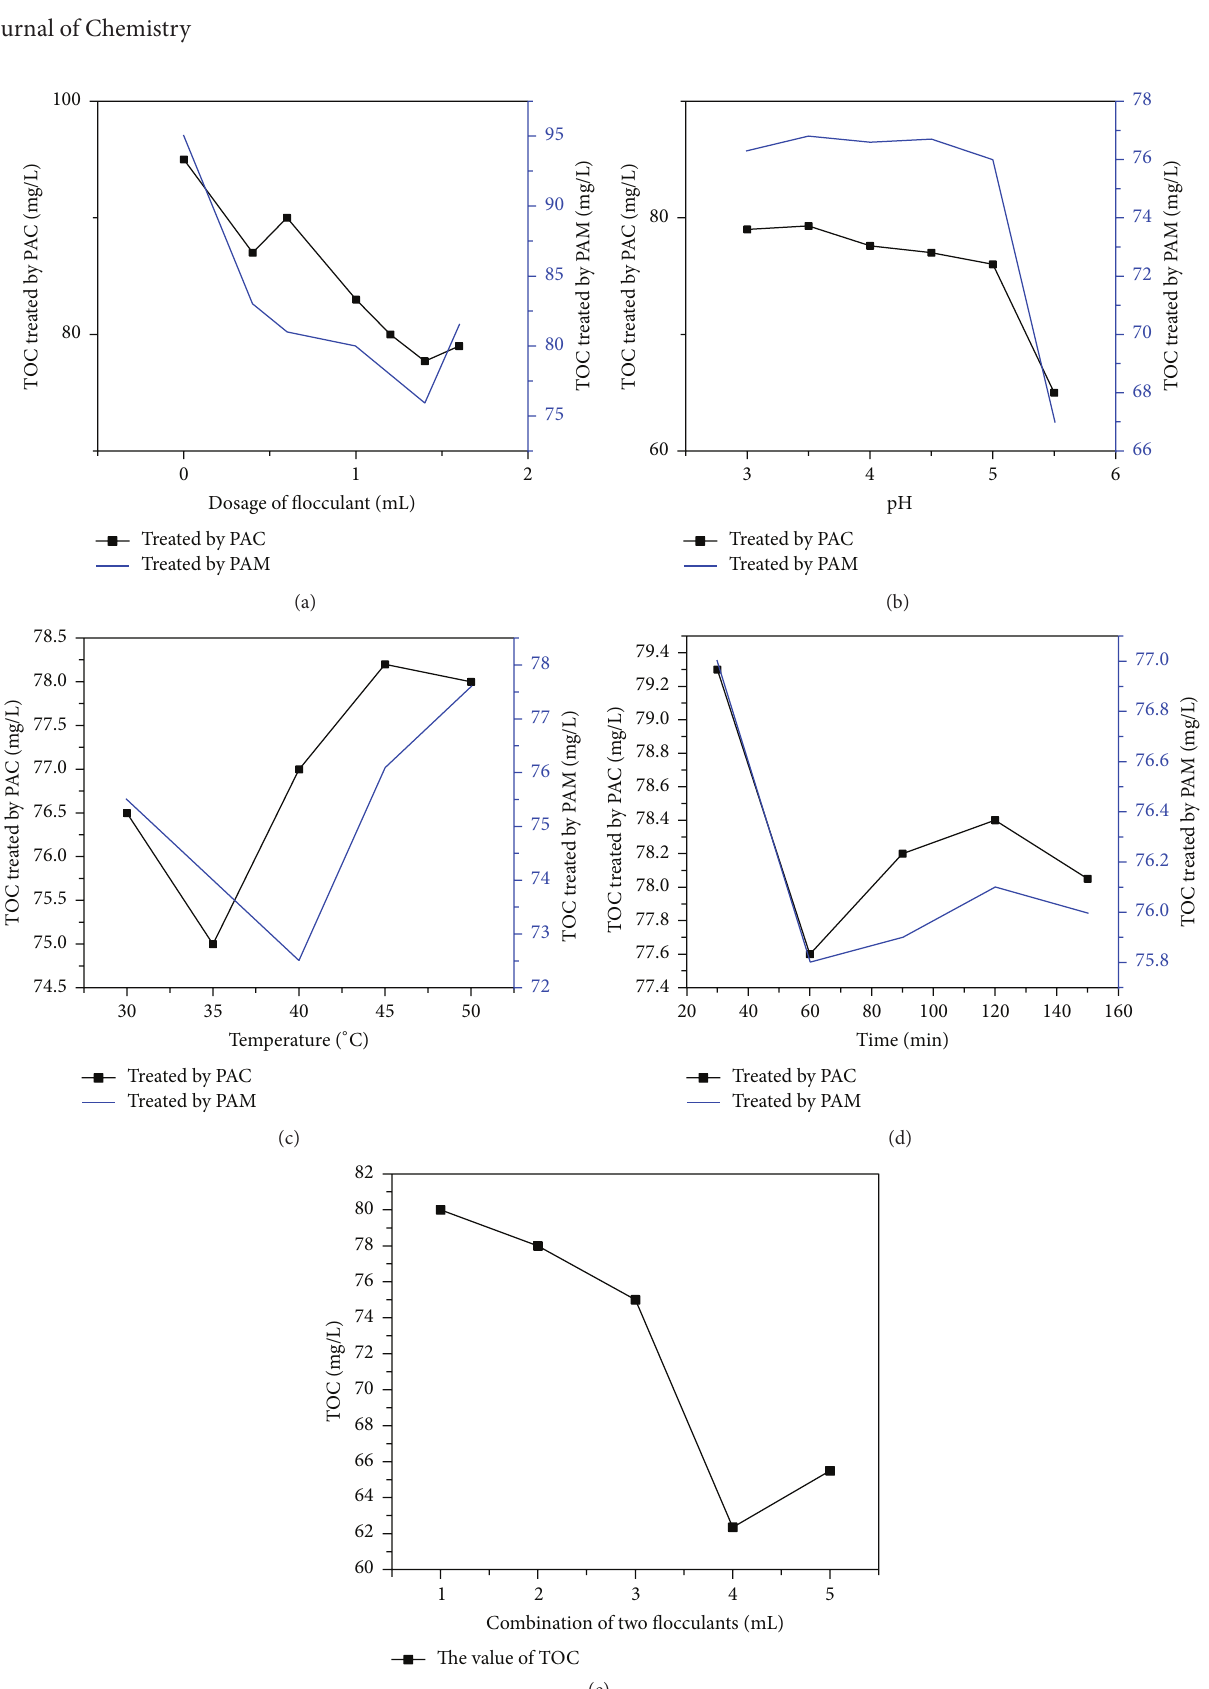
Figure 4: The impact on flocculant treatment with the change of reaction conditions (the combination of PAC and PAM represented, resp., in (e): (1) 0.7 and 0.7 mL, (2) 1 and 0.5 mL, (3) 0.5 and 1mL, (4) 1.2 and 0.4mL, and (5) 0.4 and 1.2